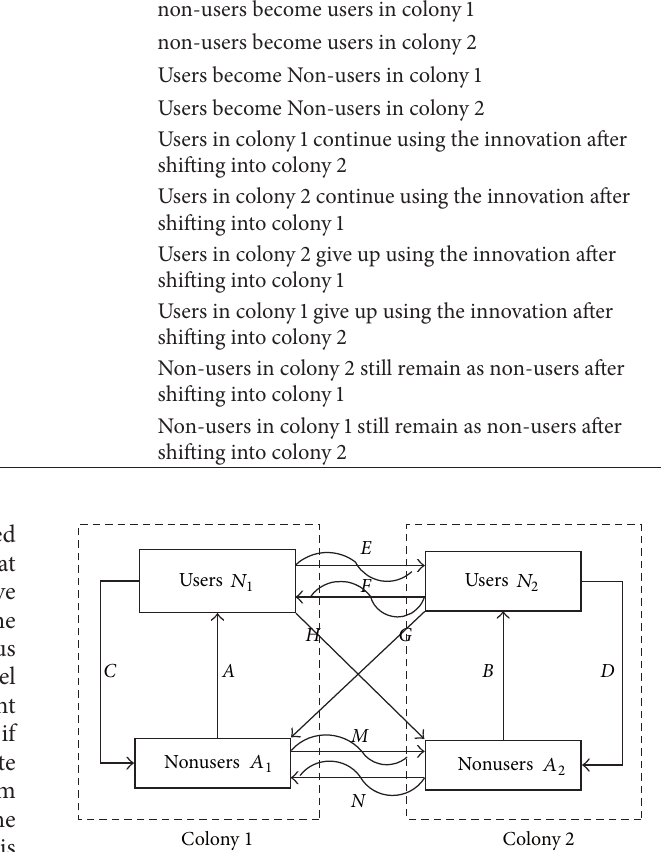
Figure 1: Customers flow diagram for innovation between two